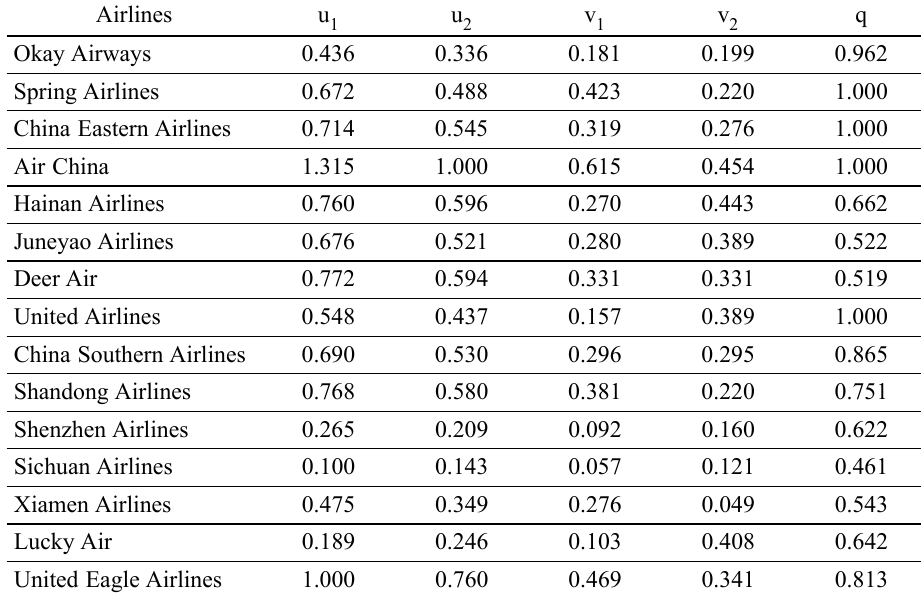
Table 16. Results and weight ratios of Chinese airlines’ relative efficiency through C 2 R